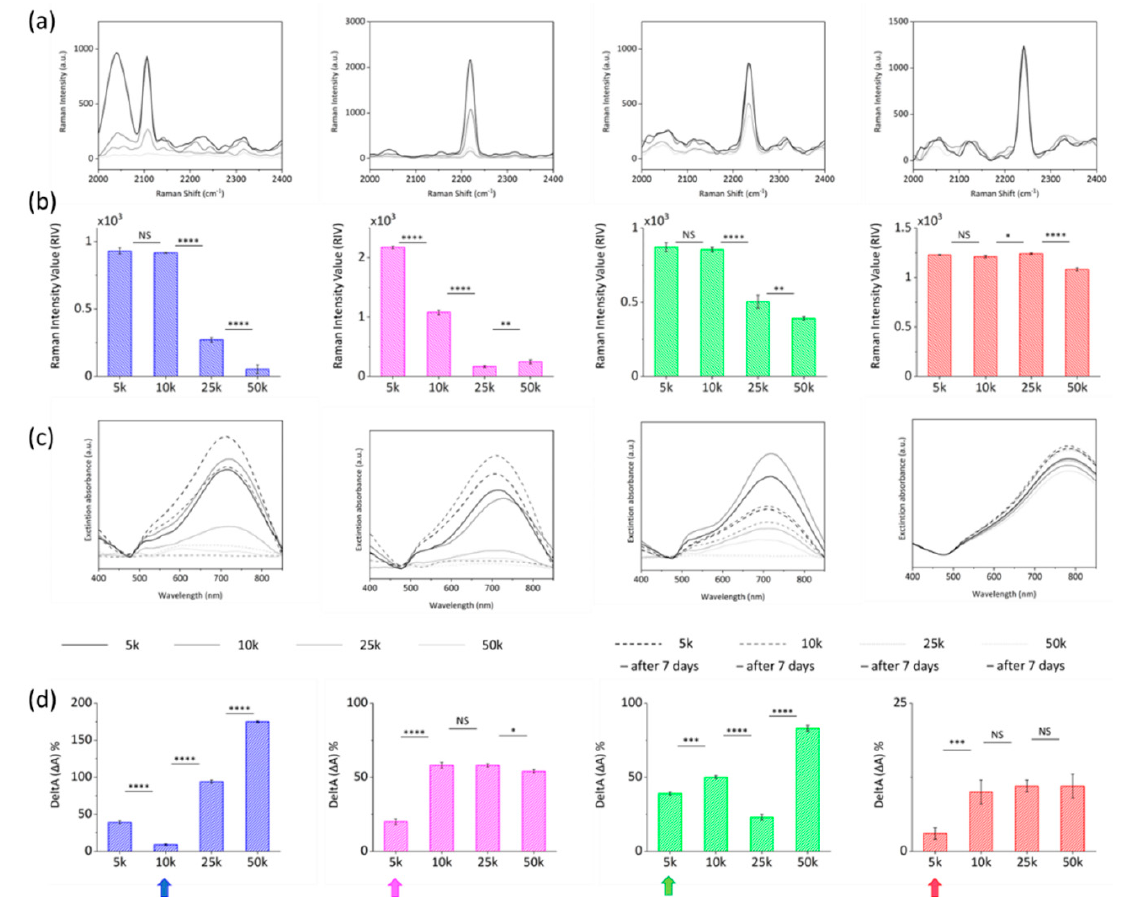
Figure 4. ( a ) Raw Raman ‐ SERS spectra and ( b ) corresponding Raman Intensity Value parameter, acquired for the RR@AuNSts solutions obtained at the different RR/NP ratios investigated ( n = 3; error bars represent s.d., NS > 0.05; * p < 0.05; ** p < 0.01; *** p < 0.001; **** p < 0.0001; an unpaired Student’s t ‐ test was performed). ( c ) Extinction spectra of RR@AuNSts solutions at the different RR/NP ratios immediately after conjugation (continue black lines) and after 7 days (dotted lines). ( d ) Corresponding DeltA values parameter ( Δ A% = (|At 0 − At 7days |/At 0 ) × 100) for each RR@AuNSts solution at the different RR/NP ratios ( n = 3; error bars represent s.d., NS > 0.05; * p < 0.05; ** p < 0.01; *** p < 0.001; **** p < 0.0001; an unpaired Student’s t ‐ test was performed). For each RRs the final condition is highlighted with a pointing arrow.